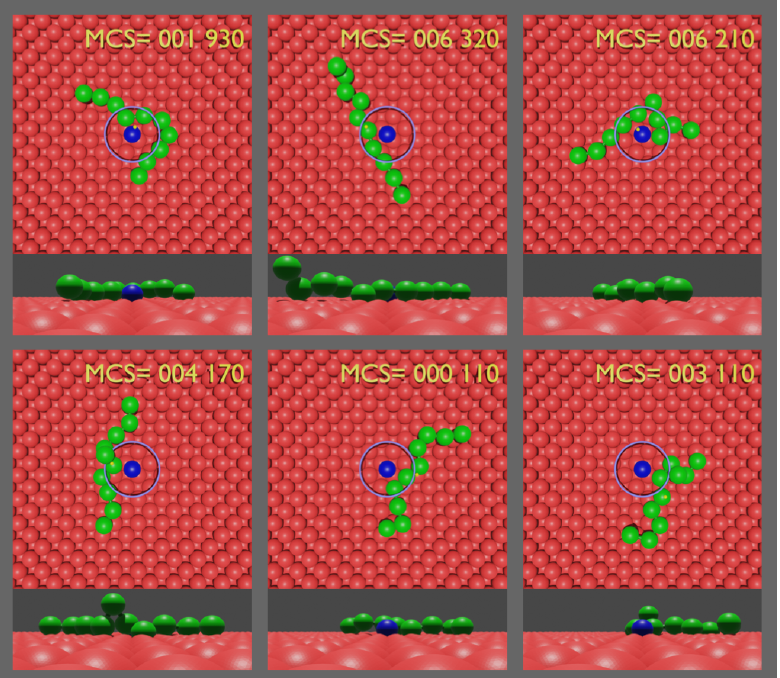
Figure 2. Final configurations of the escape time from various realizations of top and side views of a ten-monomer polymer. The side views represent a left-to-right observation of the of the top view, providing support for the requirement of a well-adsorbed polymer. In addition, notice the highly fluctuating escape times of a polymer of the set of